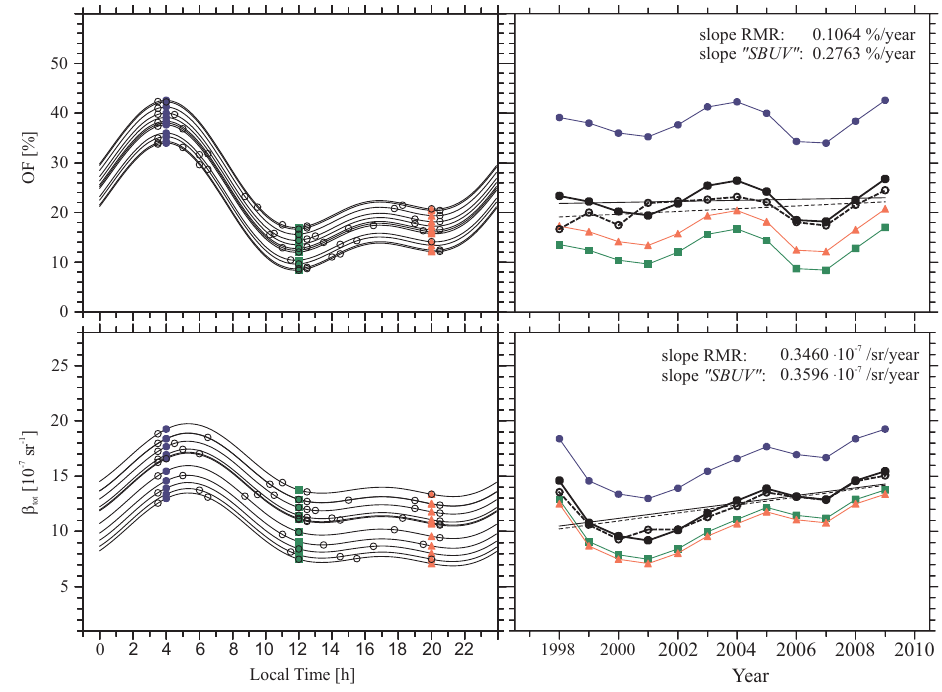
Fig. 12. Same as Fig. 11, but the diurnal behavior for each year was calculated from the 14-year mean fit coefficients (24-,